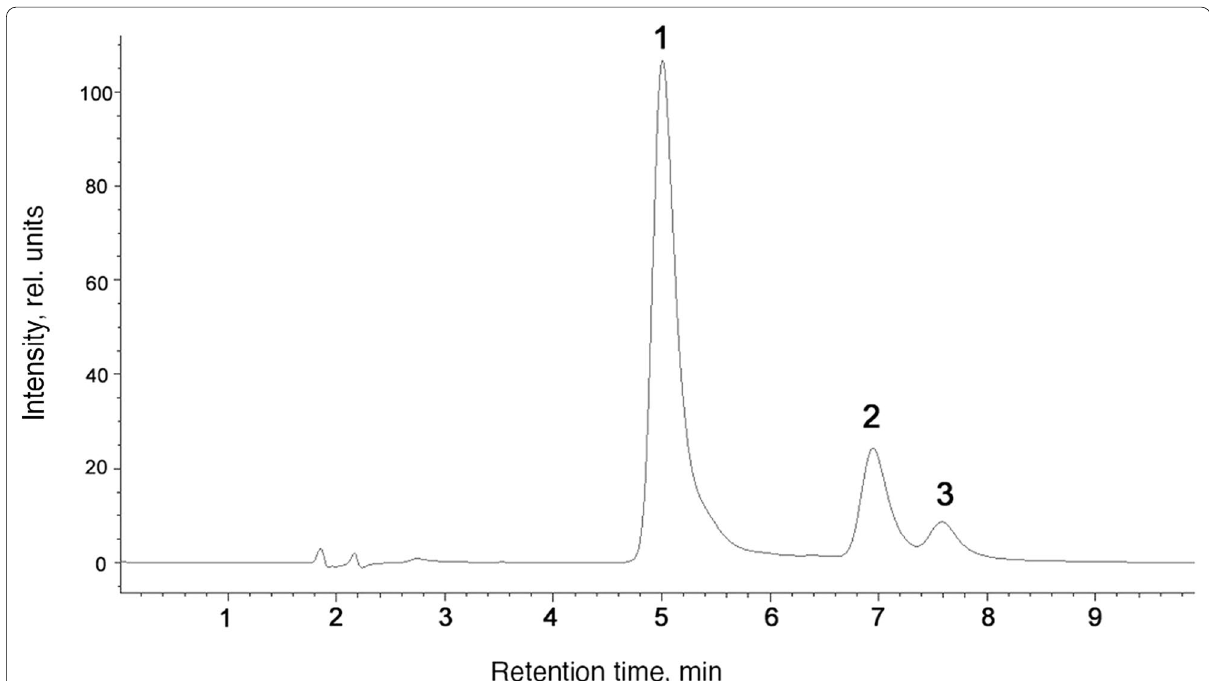
Fig. 2 Chromatogram of astaxanthin solution after incubation in chloroform for 2 days at 40 °C: (1) all- E -astaxanthin, (2) 13 Z -astaxanthin, (3) 9 Z -astaxanthin